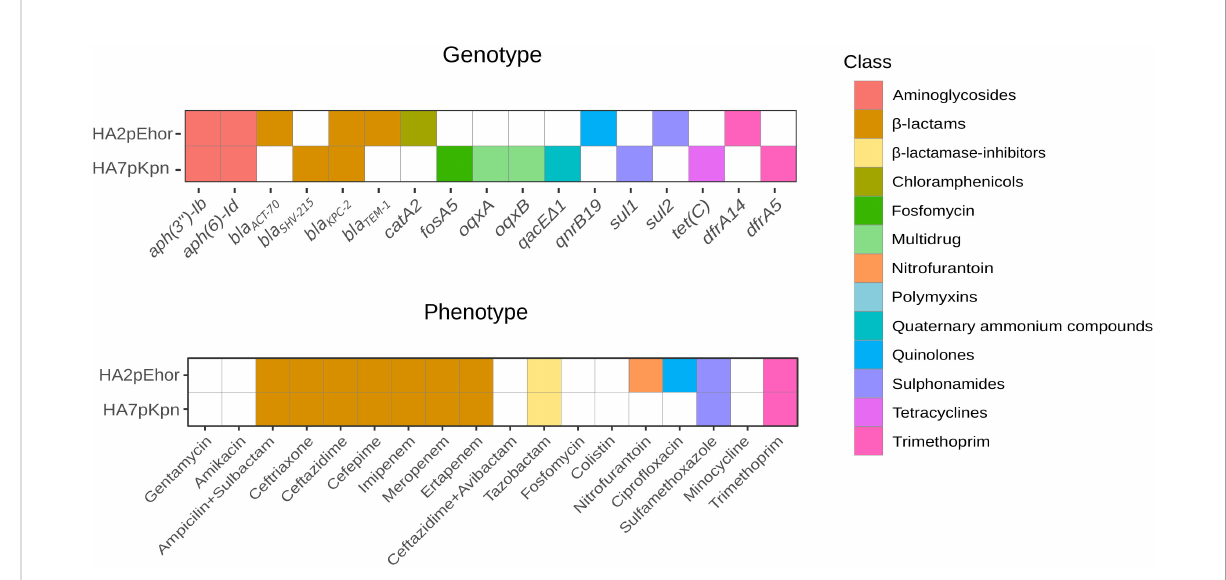
FIGURE 1 Antibiotic resistance genes and antibiotype pro fi les of E. hormaechei HA2pEho, K. pneumoniae , and HA7pKpn strains isolated from colonizations. Colored cell means presence and different colors indicate the antibiotic class for which the ARG codi fi es. The lower panel shows the resistance phenotype, and the upper panel shows the resistance genotype. The fi gure was made in R using the package